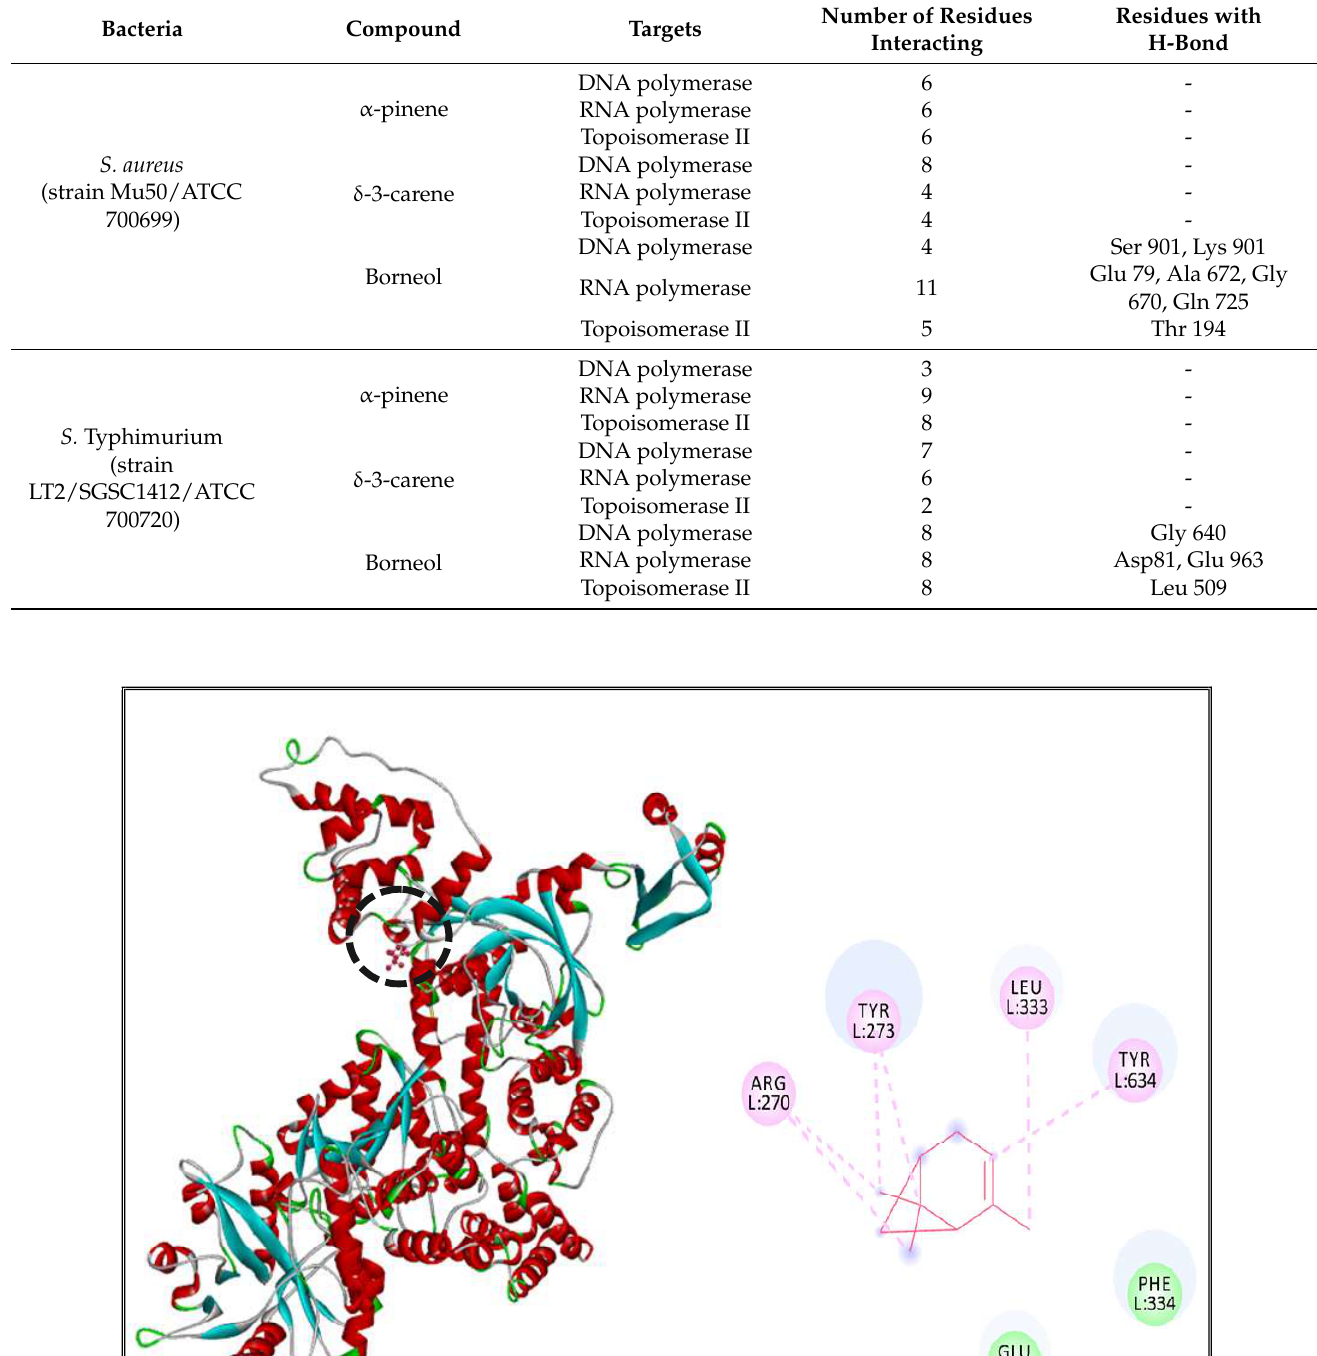
Table 8. Interaction details of (CSEO) compounds and the active sites of selected bacterial targets.